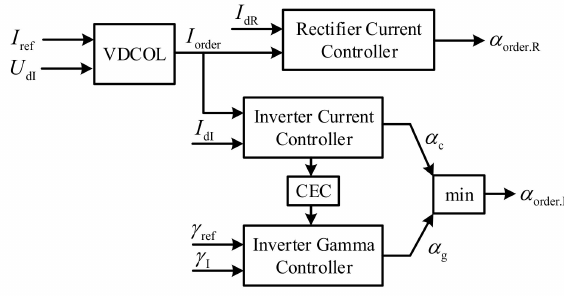
Figure 6. DC control